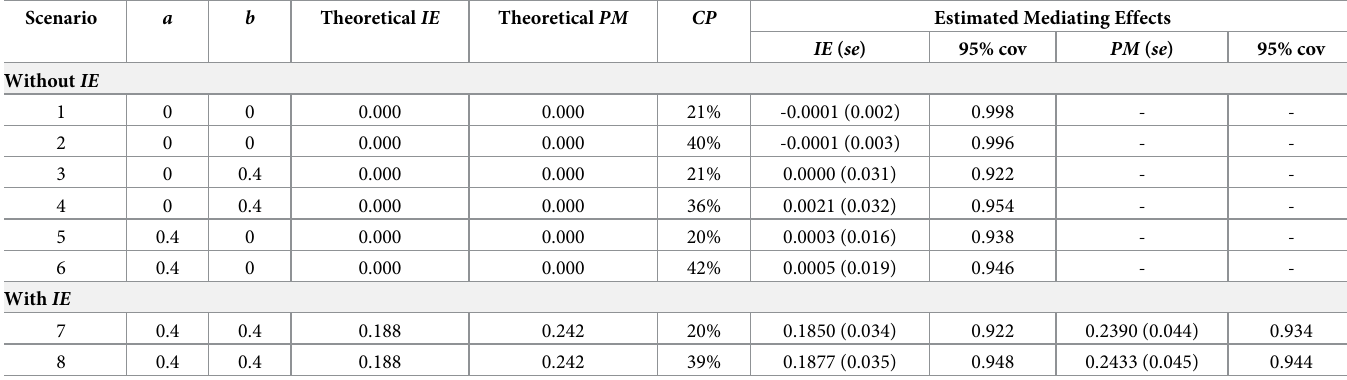
Table 4. Continuous outcome: Means and standard errors (se) of indirect effects ( IEs ) and proportions of the total effect mediated ( PMs ); and coverage probabili- ties (cov) of the 95% confidence intervals for the estimations of IE and PM , given the minor allele frequency (MAF) = 0.3.